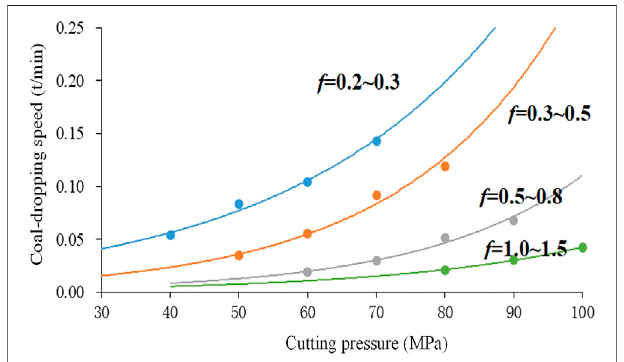
FIGURE 6 | The change curve between the jet pressure and the coal- dropping